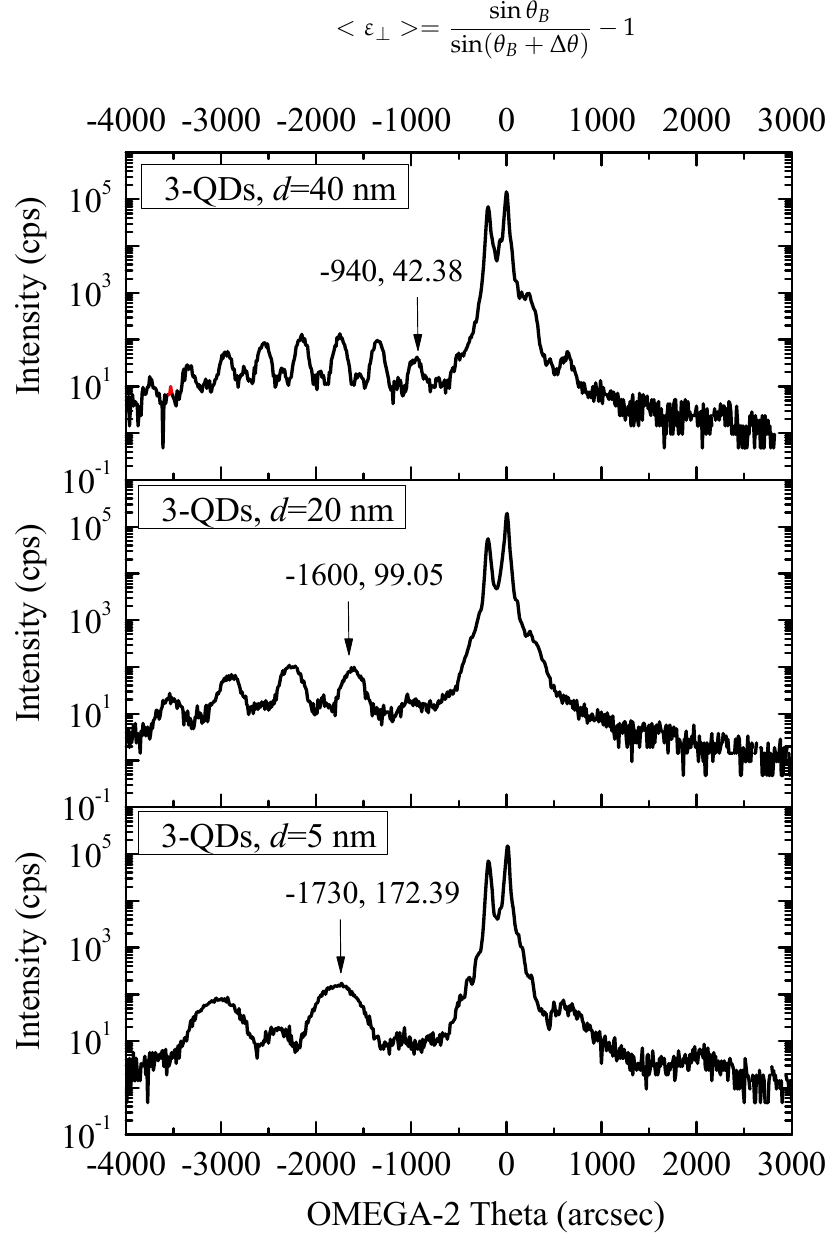
Figure 3. X-ray diffraction curves for the triple-layer In 0.75 Ga 0.25 As QDs by varying GaAs spacer thickness with 40 nm, 20 nm, and 5 nm,